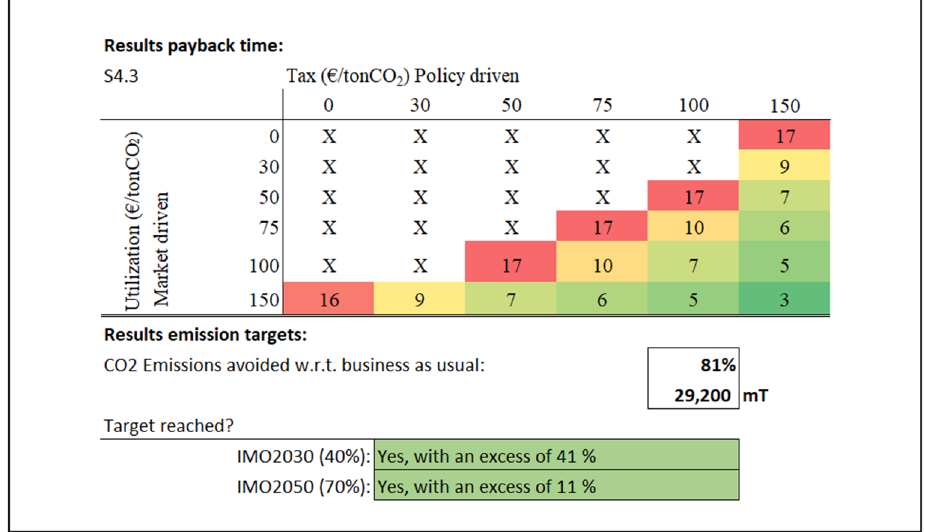
Figure 4. Results scenario 4.3. Best result from first iteration.